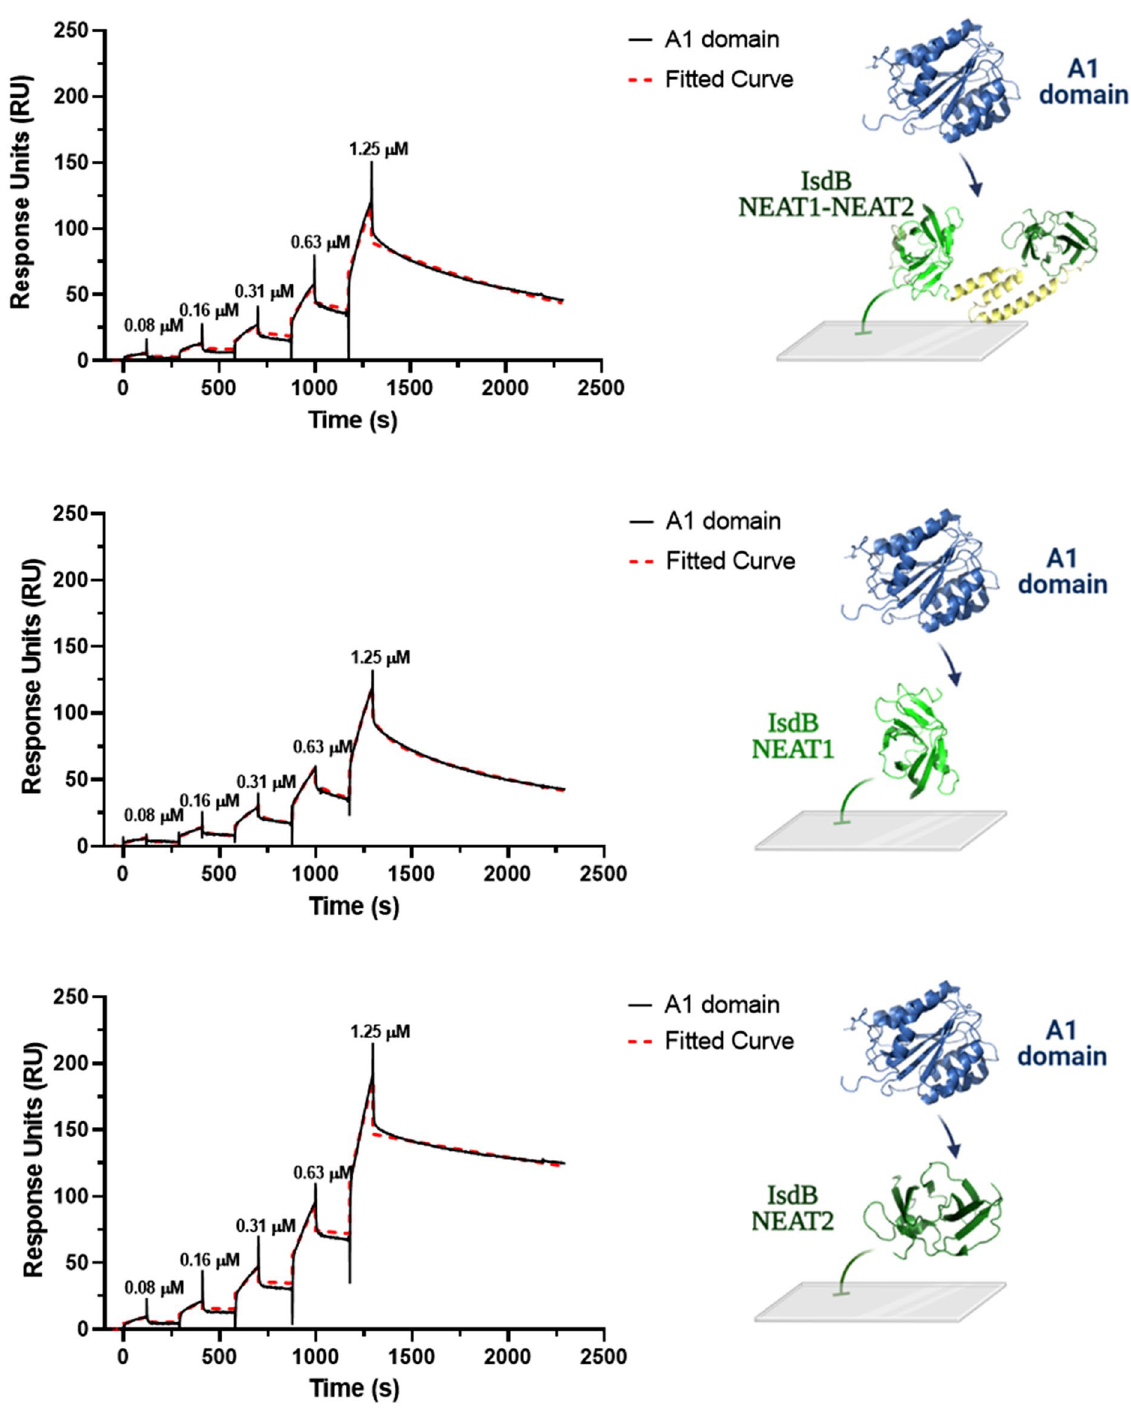
Figure 6. BIAcore analysis of A1 binding to IsdB proteins. 6xHis-tagged IsdB NEAT1-NEAT2 or isolated NEAT1 and NEAT2 were immobilized on a NTA-Ni 2+ sensor chip, while increasing concentrations of recombinant A1 (0–1.25 μM), lacking the 6xHis tag, were loaded in the mobile phase, following the single- cycle operation mode. Sensorgrams were subtracted from reference flow cell data and then fitted with the equation describing the heterogeneous ligand binding model to obtain the values of K D and RUmax for the two ligand populations considered (L1 and L2) along with their relative abundance. IsdB NEAT1–NEAT2: K D1 = 1.7 ± 0.3 μM; K D2 = 0.9 ± 0.2 μM; RU max1 = 354 ± 21; RU max2 = 355 ± 23; L1 and L2 = 50%. NEAT1: K D1 = 53 ± 2 μM; K D2 = 5.3 ± 0.3 μM; RU max1 = 948 ± 40; RU max2 = 2705 ± 125; L1 = 26%, L2 = 74%. NEAT2: K D1 = 0.3 ± 0.1 μM; K D2 = 0.4 ± 0.1 μM; RU max1 = 529 ± 51; RU max2 = 527 ± 39; L1 and L2 = 50%. All measurements were carried out at 25 °C, in PBS containing 0.005% v/v Tween